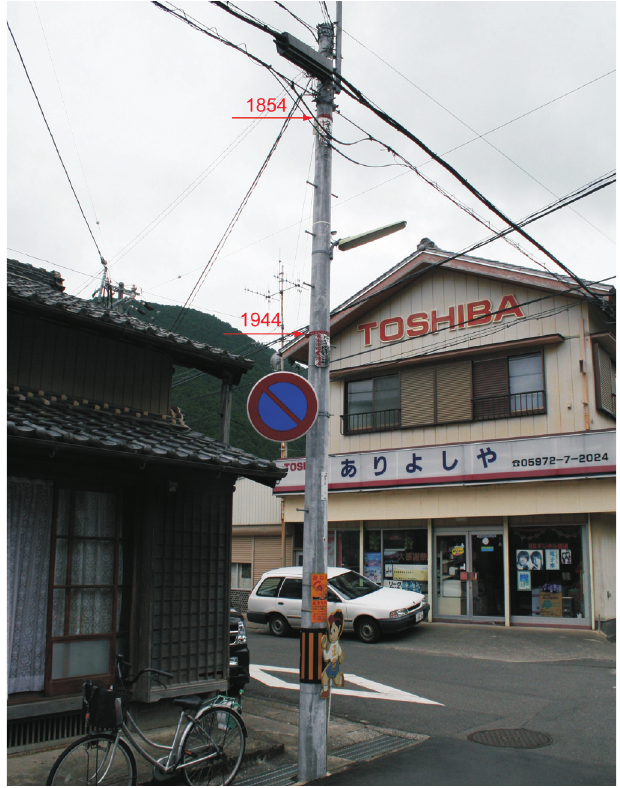
Figure 3. Display of tsunami heights (in red on pole) in Kata village, Owase